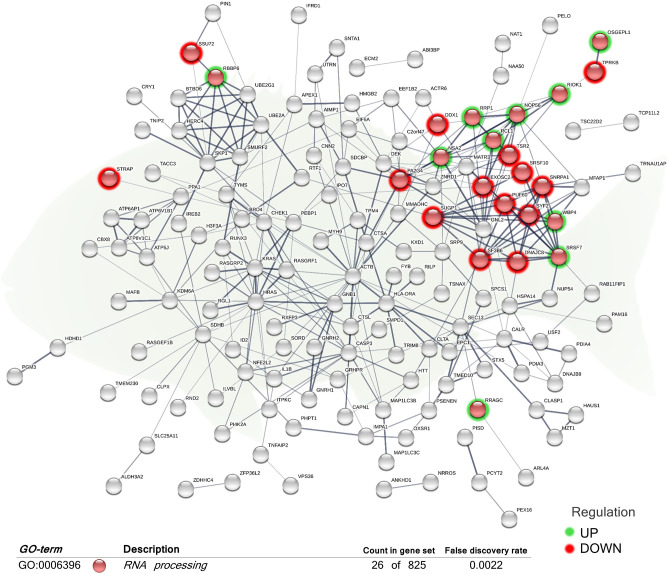
Functional biological network of the differentially expressed genes (DEGs) in the skin of juvenile gilthead seabream (Sparus aurata) fed a diet supplemented with a blend of garlic essential oil, carvacrol, and thymol. Green-shaded nodes represent up-regulated genes and red-shaded nodes represent down-regulated genes. Graphic keys and network stats: number of nodes = 203; number of edges = 341; average node degree = 3.36; average local clustering coefficient = 0.4; expected number of edges = 286; PPI enrichment p-value = 0.000807. Gene Ontology (GO) definition, count of DEGs within the biological process and respective false discovery rate are described in the graphical figure legend (bottom). For details, please refers to Supplementary Table 2.